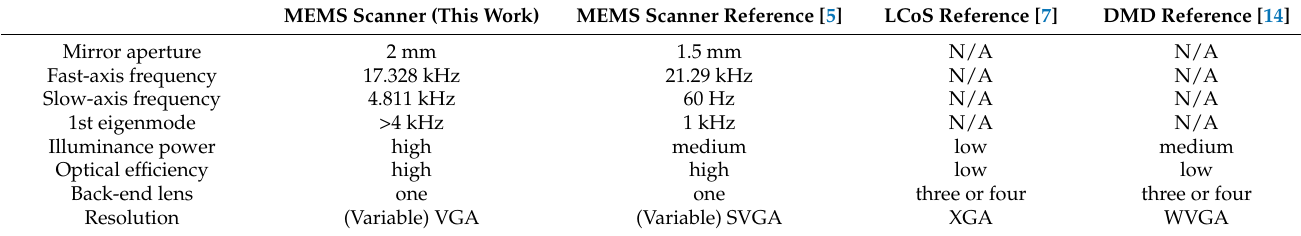
Table 1. Performance comparison of different automotive headlight